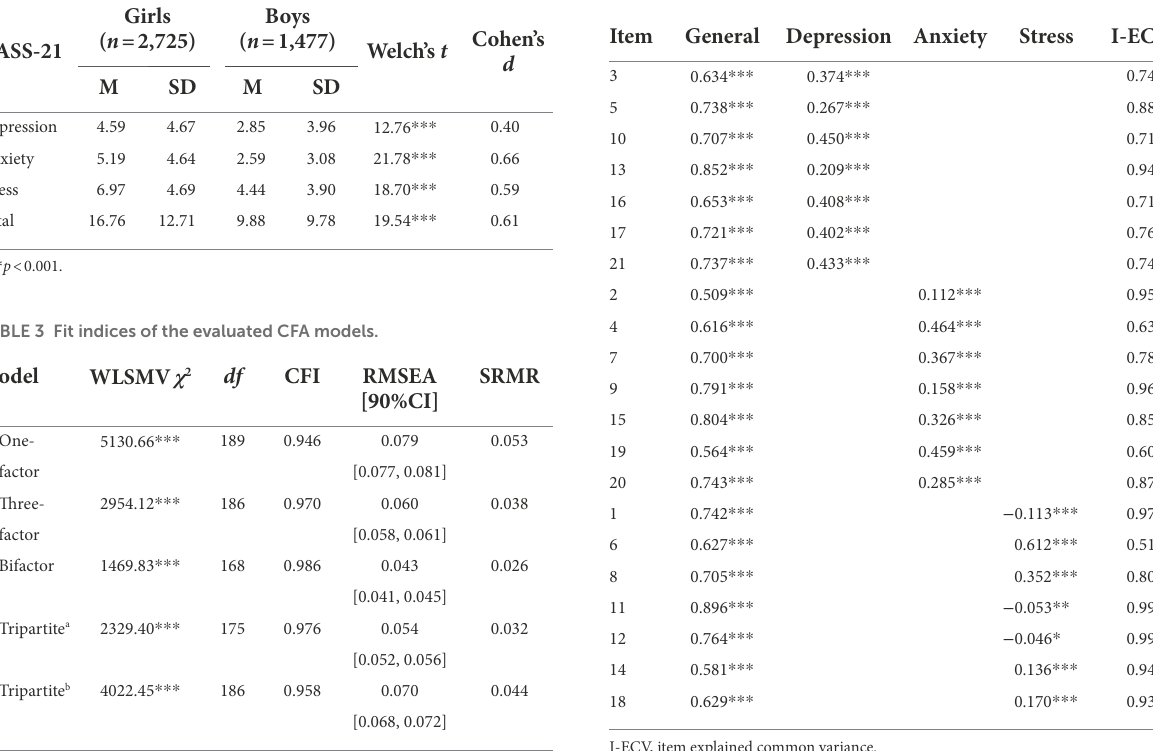
TABLE 2 Mean differences between girls and boys.